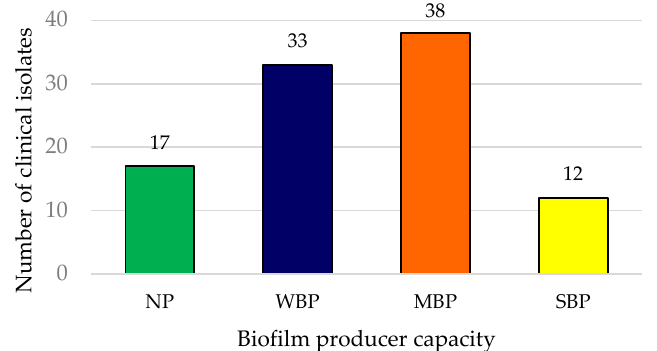
Figure 1. Distribution of UPEC clinical isolates by biofilm-formation capacity. NP: not a biofilm producer; WBP: weak biofilm producer; MBP: moderate biofilm producer; SBP: strong biofilm producer.